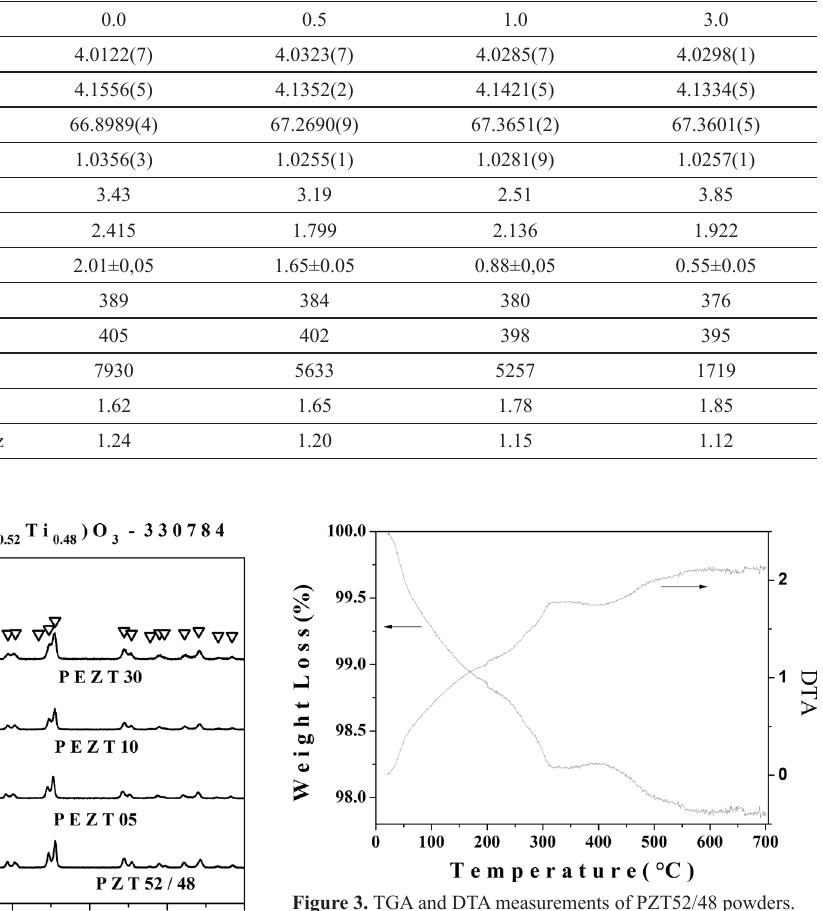
Table 2. Parameters of unit cell and some properties of Pb(Zr